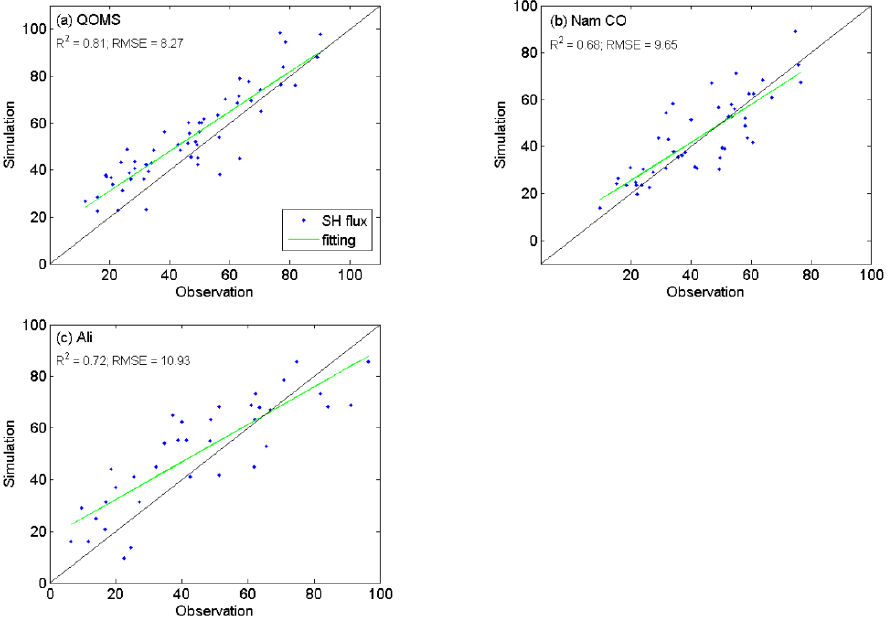
Figure 2. Comparison of simulated and observed monthly mean SH fluxes (Wm −2 ) at the QOMS station ( a ), Nam CO station ( b ), and Ali station ( c ). The green line is the best-fit line.